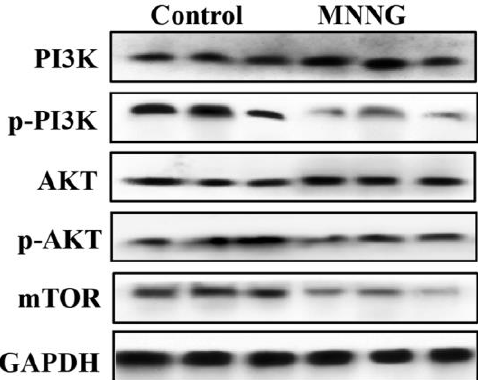
Figure 2. MMNG decreased the PI3K/AKT pathway activation in the gastric tissues of rats. Rats were exposed to MNNG (100 mg/kg BW) every 5 days for 12 weeks. MNNG inhibited the expres- sions of phosphorylated PI3K, phosphorylated AKT, and mTOR. Tissues were from n = 3 rats as representative images.